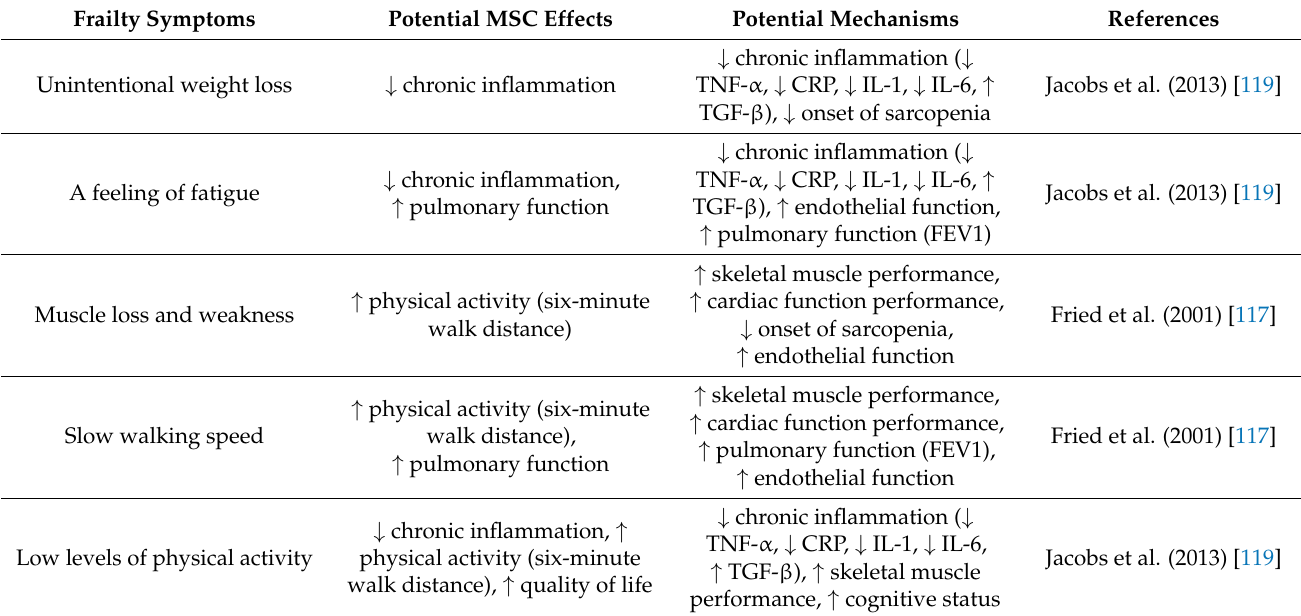
Table 1. Potential effects and mechanism of mesenchymal stem cells in patients with frailty.